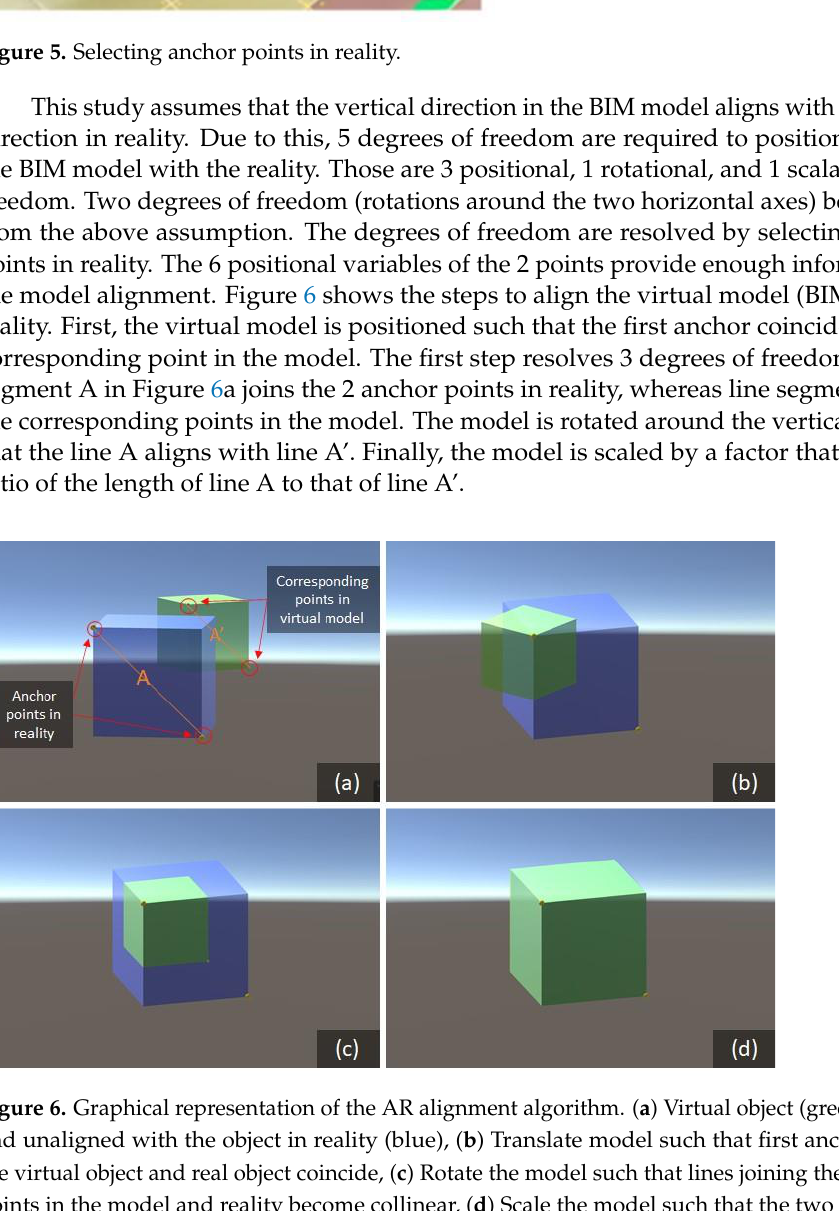
Figure 6. Graphical representation of the AR alignment algorithm. ( a ) Virtual object (green) unscaled and unaligned with the object in reality (blue), ( b ) Translate model such that first anchor point of the virtual object and real object coincide, ( c ) Rotate the model such that lines joining the two anchor points in the model and reality become collinear, ( d ) Scale the model such that the two anchor lines are of equal length.